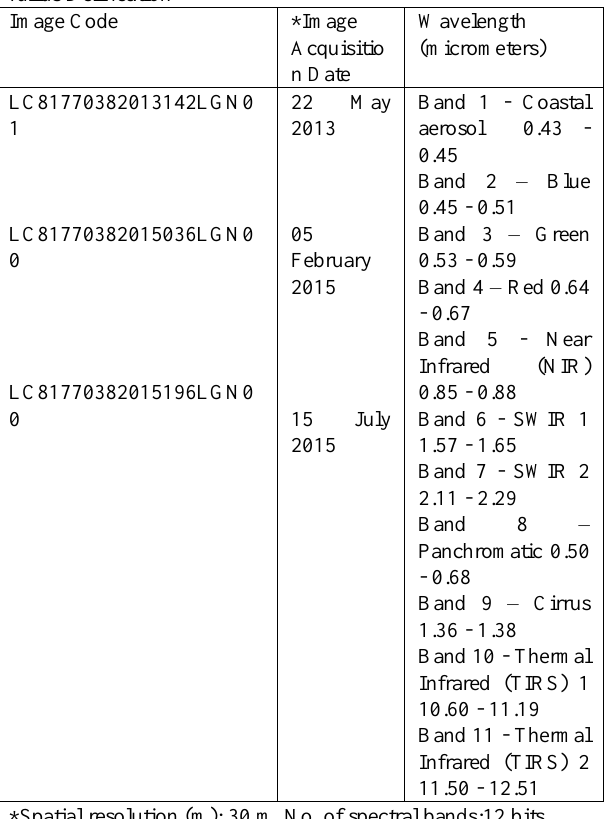
Table (1) Characteristics of satellite sensors data used in